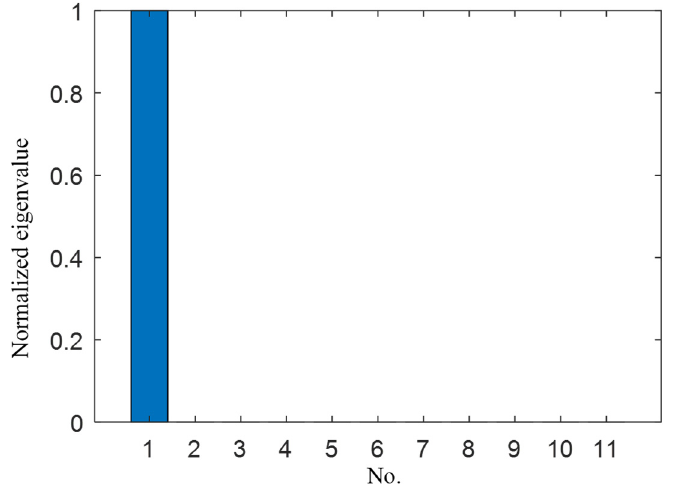
Figure 4. Normalized eigenvalue distribution of Case I.